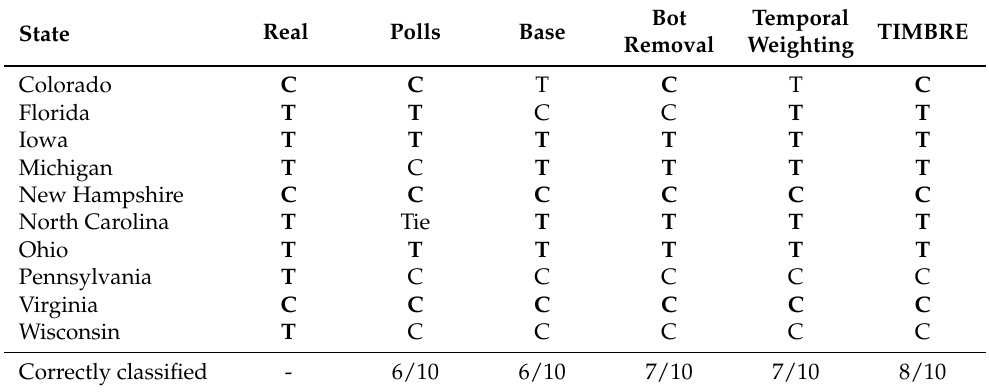
The winning candidate for each state is highlighted in bold. Table 4. Results comparison in terms of winning faction and analysis of the contribution brought by each step of TIMBRE. “C” and “T” stand for Clinton and Trump respectively. State